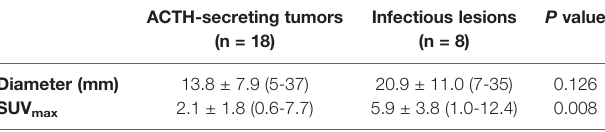
TABLE 3 | Imaging characteristics of ectopic Cushing syndrome patients.